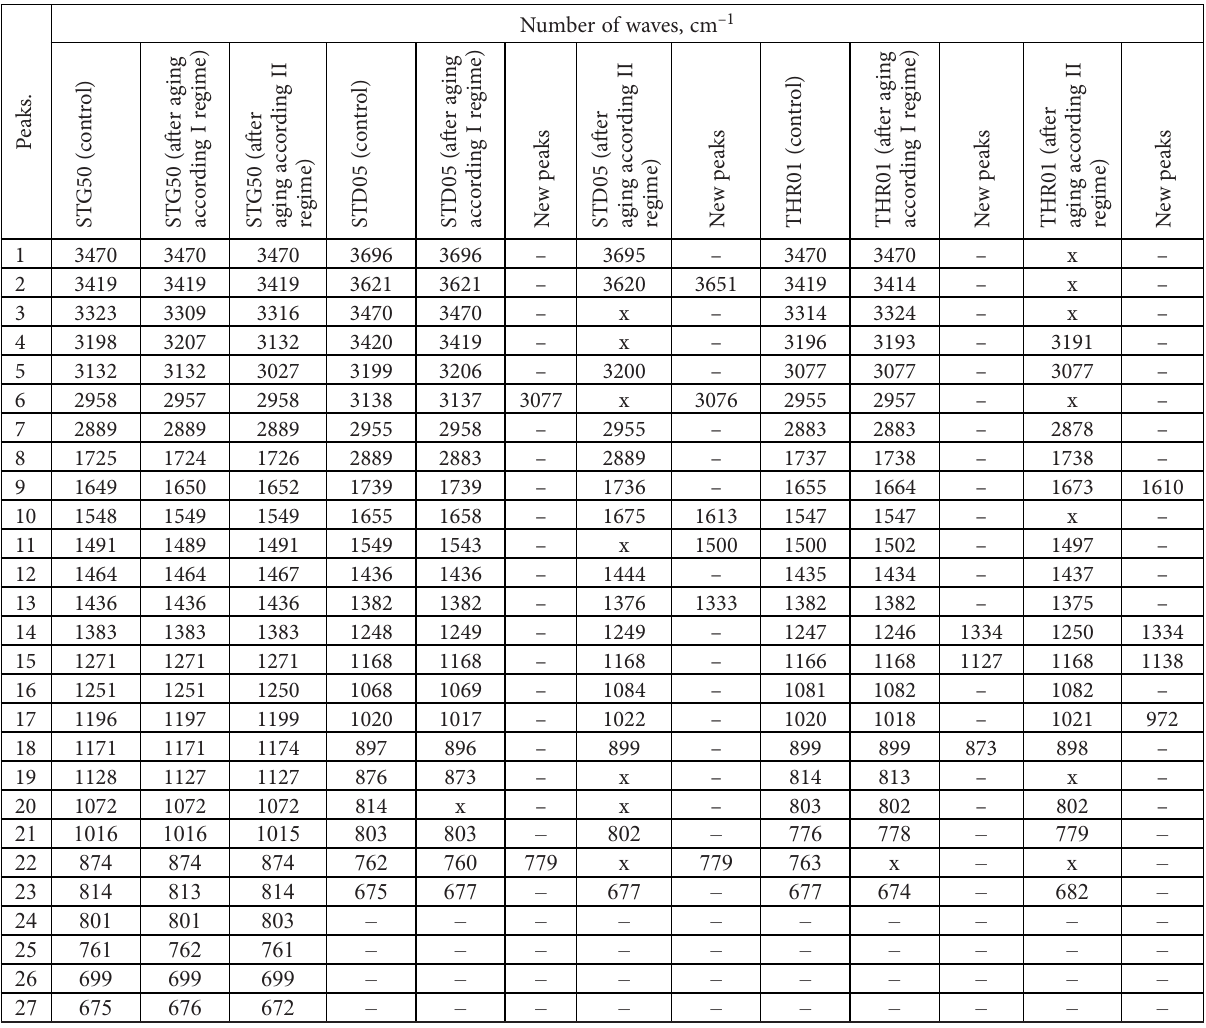
Table 5. Intumescent fire protective coatings THR01, STD05 and STG50 frequencies